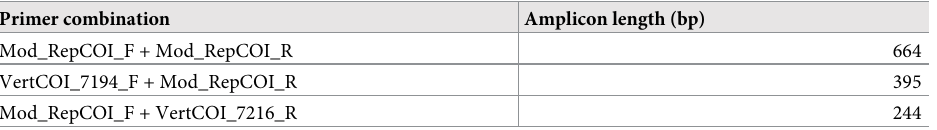
Table 2. Primer combinations used in this study. Primer